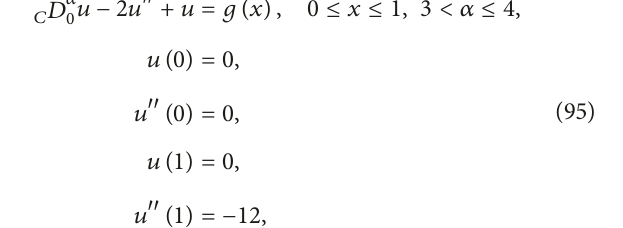
that all of the data points after 𝑛 = 7 lie almost on a straight line which demonstrates the maximal errors ME 𝑛 are reduced approximately at an exponential